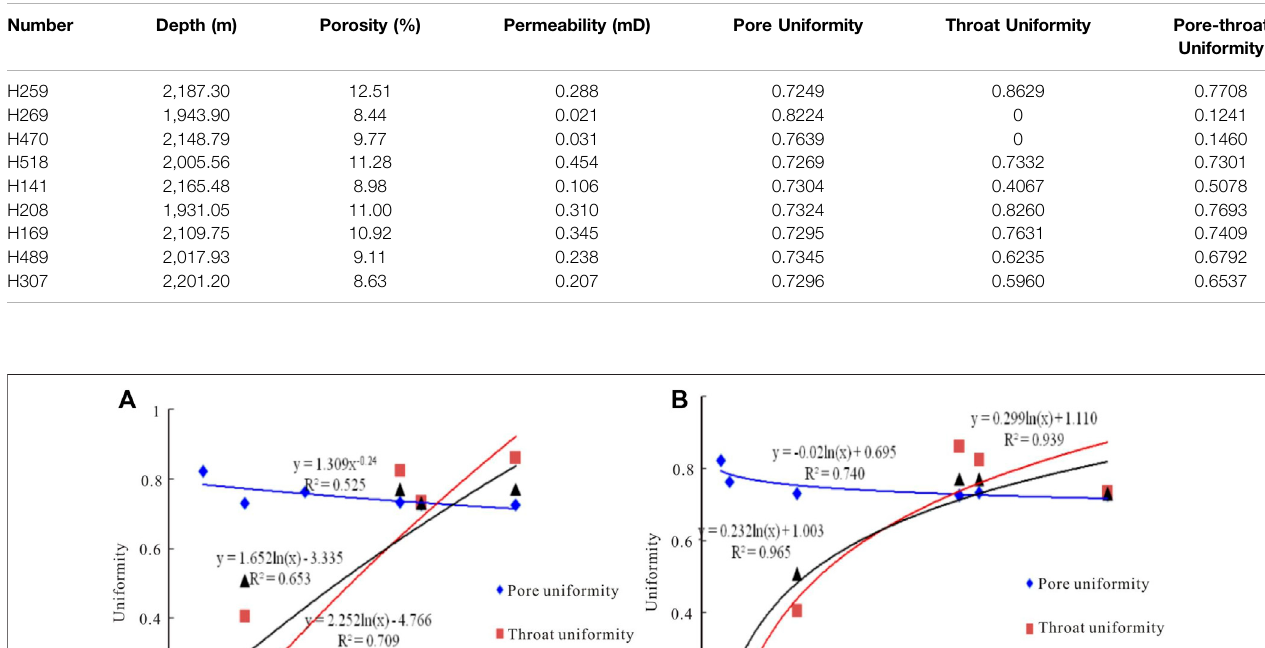
Frontiers in Earth Science |